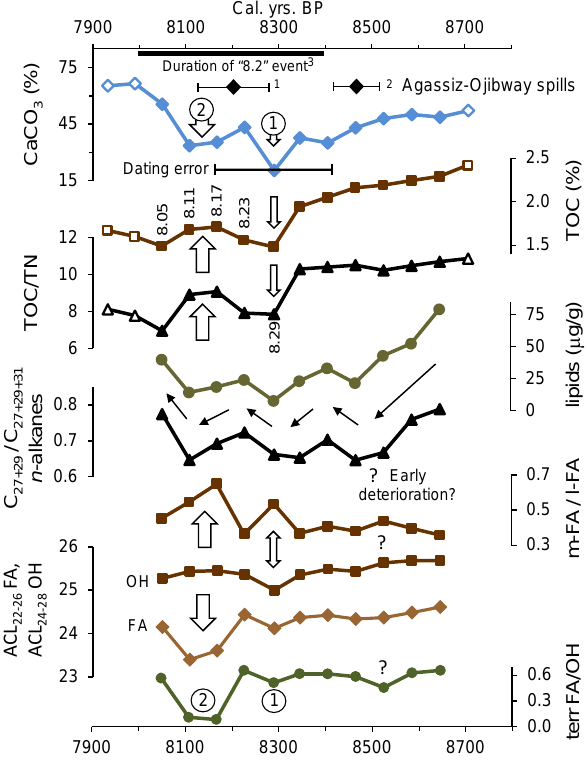
Figure 6. Records from elemental (CaCO 3 , TOC, TOC / TN) and lipid biomarker analyses (closed symbols) of sediment core Lz1120 over the course of the 8.2ka climate deterioration. White arrows indicate contrasting response of elemental and biomarker prox- ies in response to the reduced carbonate supply, i.e. in carbon- ate minima. Black diamonds indicate Agassiz–Ojibway freshwa- ter spillages dated by 1 Roy et al. (2011) and 2 Lajeunesse and St- Onge (2008); 3 duration of 8.2 climate deterioration (Barber et al., 1999). While n -alkane composition (C 27 and C 29 relative to C 31 ) appears to co-vary with the total concentration of lipids in the sed- iment (indicated by the black arrows), proxies based on n -alkanoic acid and n -alcohol distribution appear to correspond to the environ- mental changes indicated by the variable supply of carbonate and non-carbonate